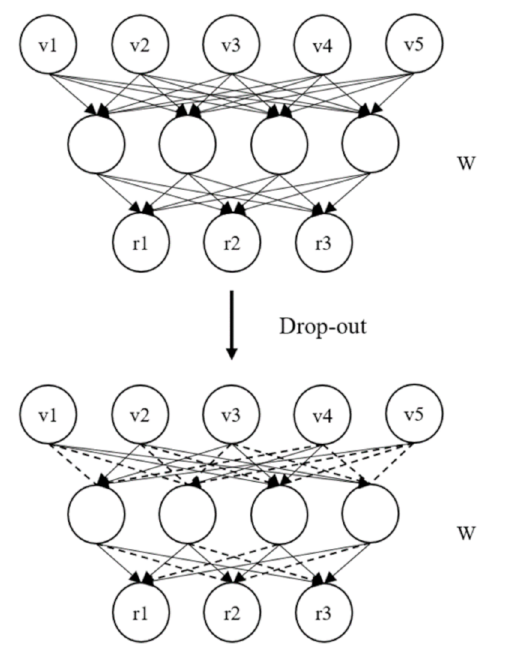
Figure 8. The overfitting principle.